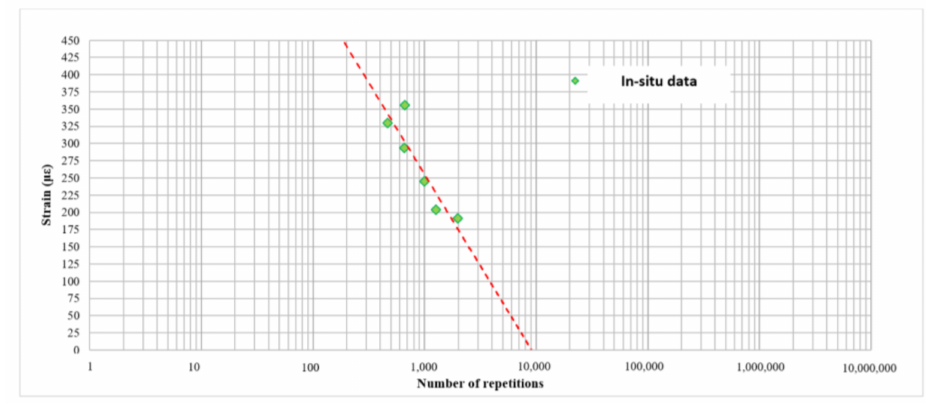
Figure 9. RTM performance criteria by means of in-situ data results.